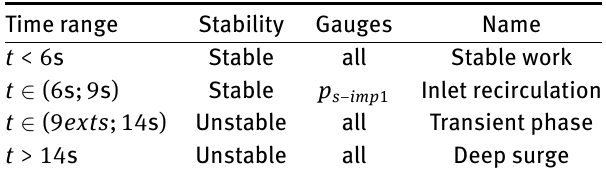
Table 2: Working regimes identified based on CWT analysis of sig- nals gathered at all